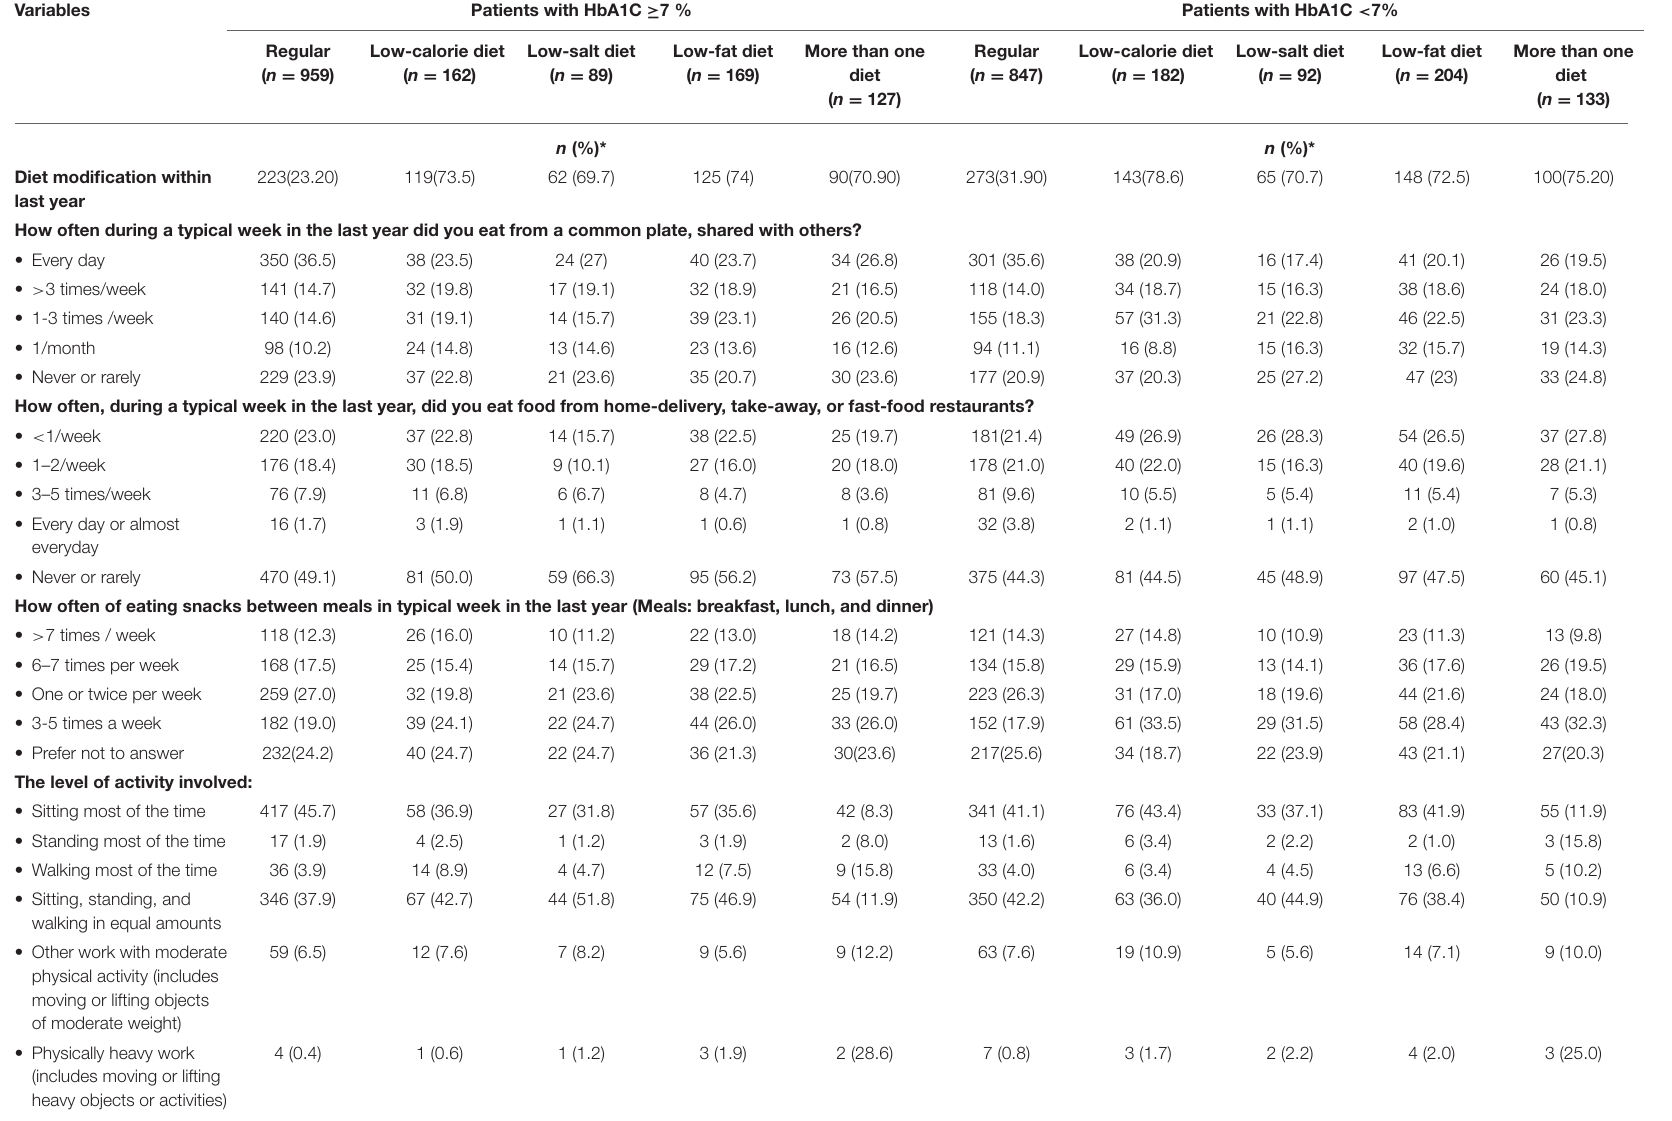
TABLE 2 | Dietary habits and sedentary behavior of the study sample.